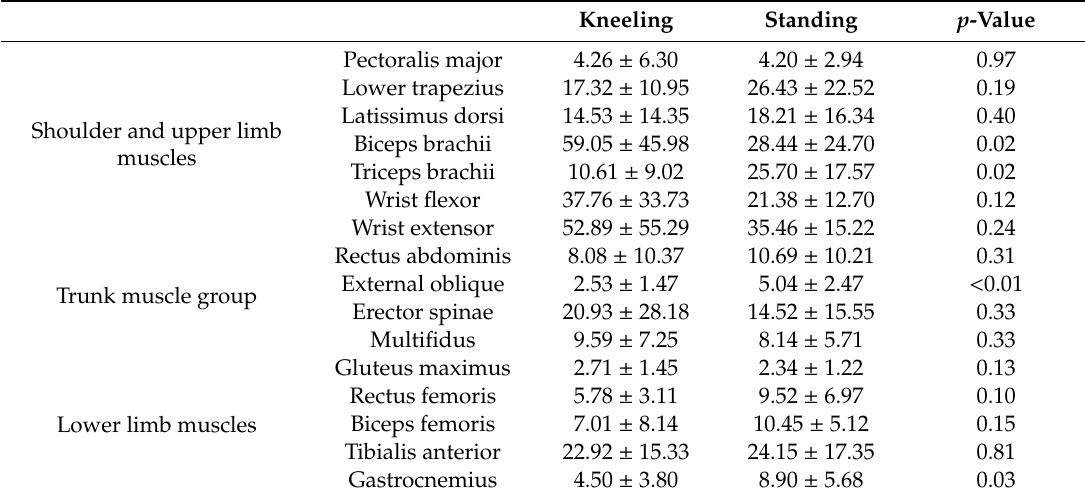
Table 3. Maximum activation of each muscle in di ff erent postures ( µ